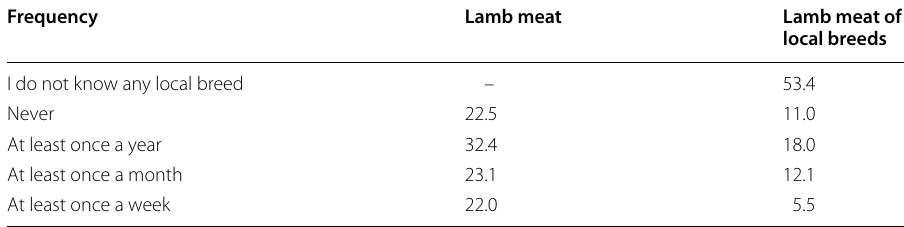
Table 3 Share of respondents buying lamb meat and lamb meat of local breeds (values in